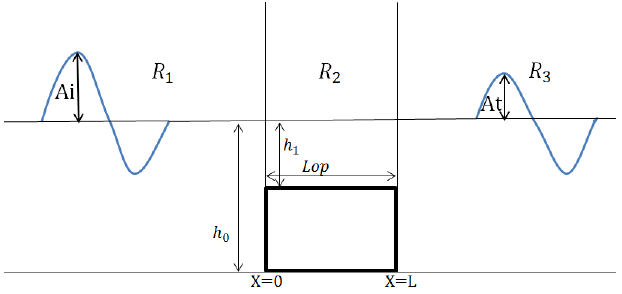
Figure 2. Region diagram of a single breakwater of optimal